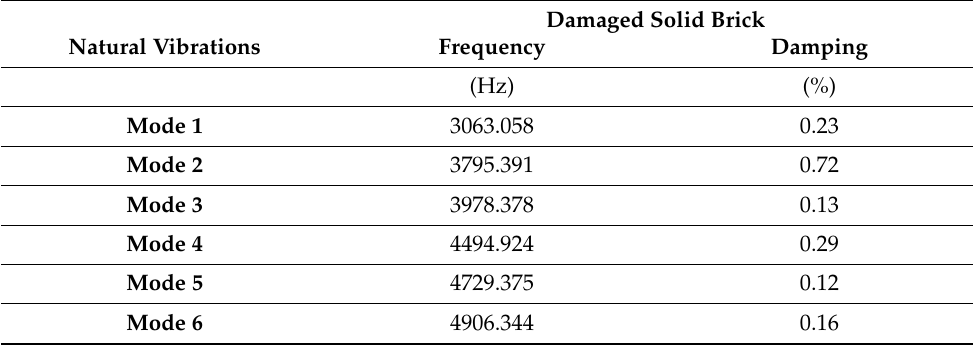
Table 4. List of natural frequencies and damping coefficients for a damaged full ceramic brick.